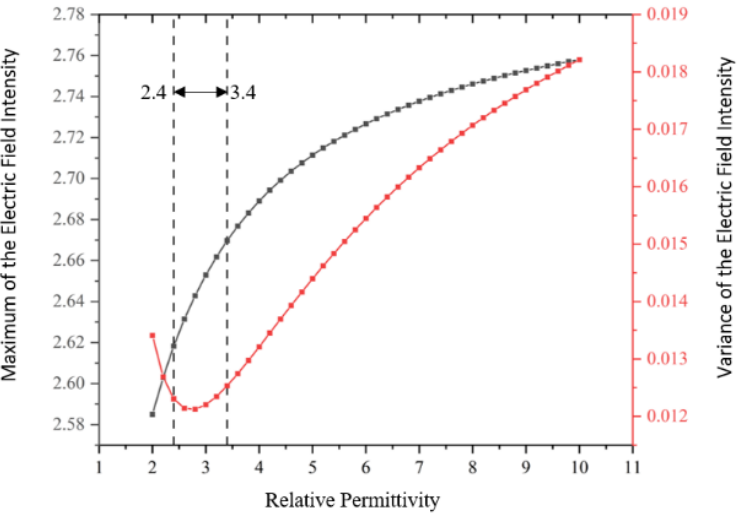
Figure 14. Maximum and variance of the electric field intensity.